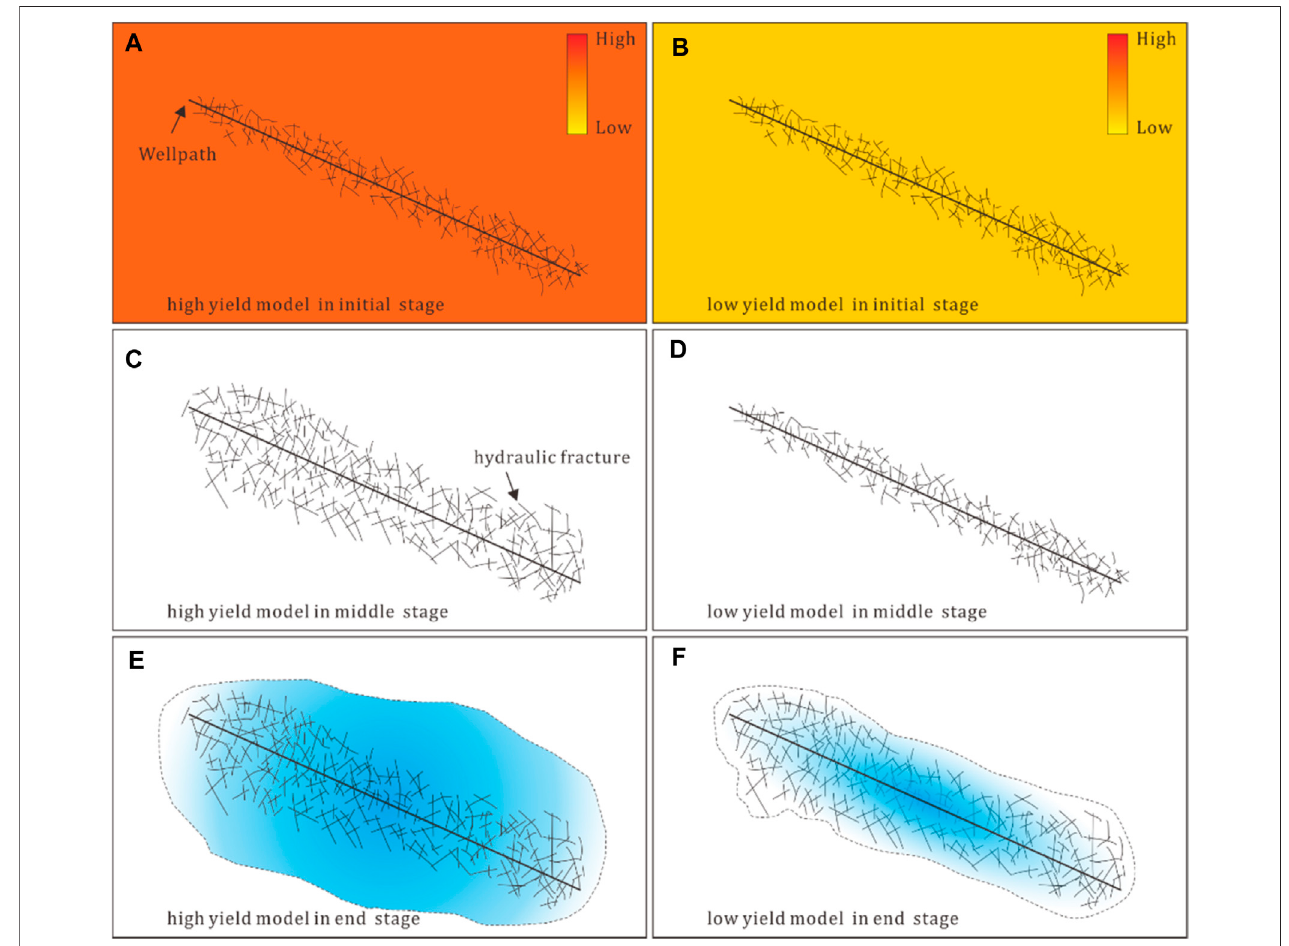
FIGURE 6 | The in fl uence model of geological – engineering – production process of shale gas well.